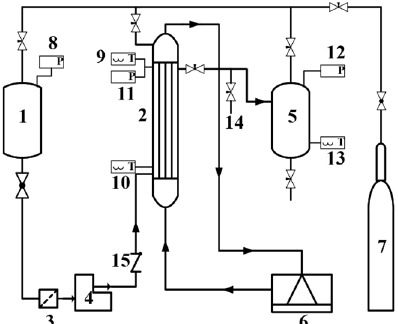
Figure 1. Schematic diagram of the experimental apparatus for catalytic performance evaluation. 1. AcH feed storage tank, 2. tubular reactor, 3. foot valve, 4. plunger pump, 5. product